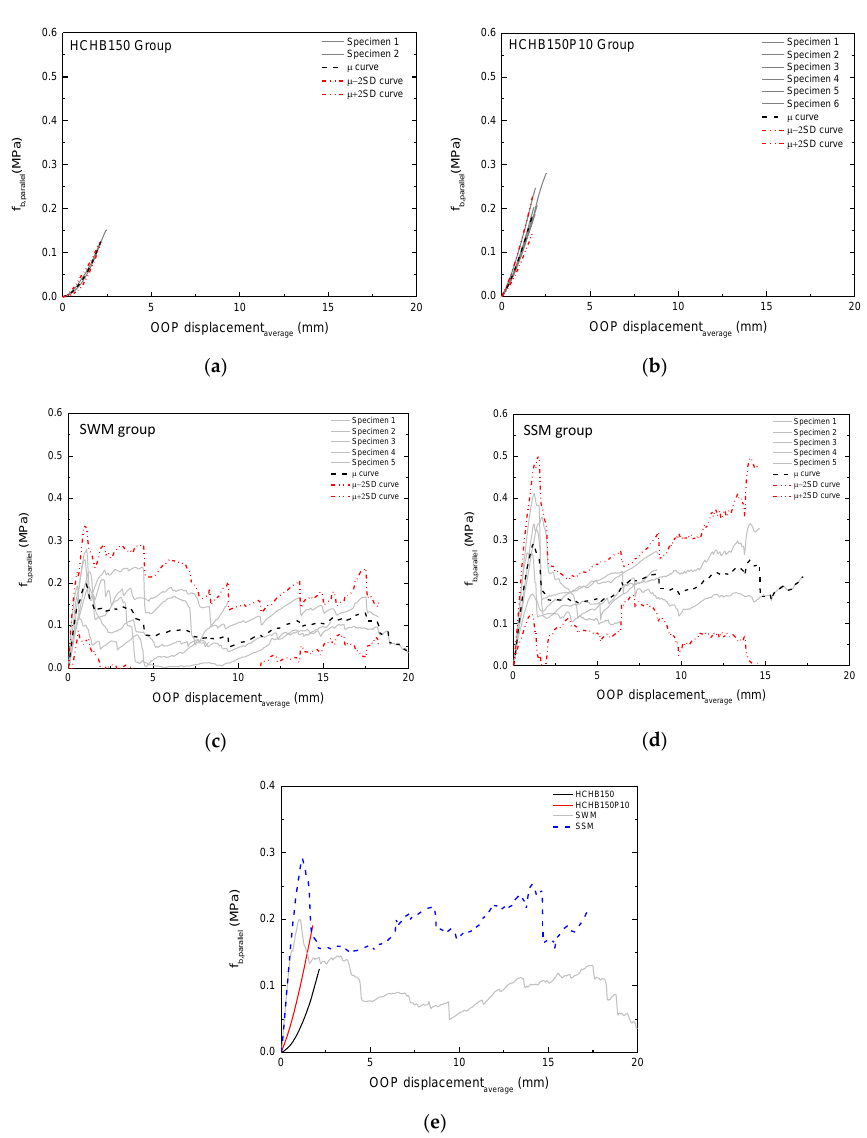
Figure 5. Force-displacement results: ( a ) HCHB150; ( b ) HCHB150P10; ( c ) SWM; and ( d ) SSM; and ( e ) global comparison (average curves).